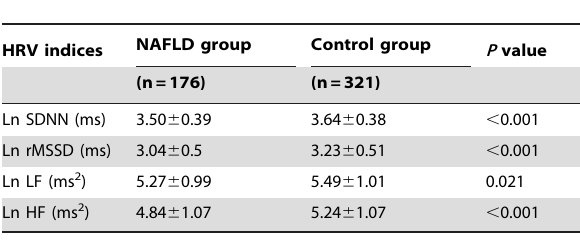
Table 2. Comparison of HRV indices between NAFLD subjects and